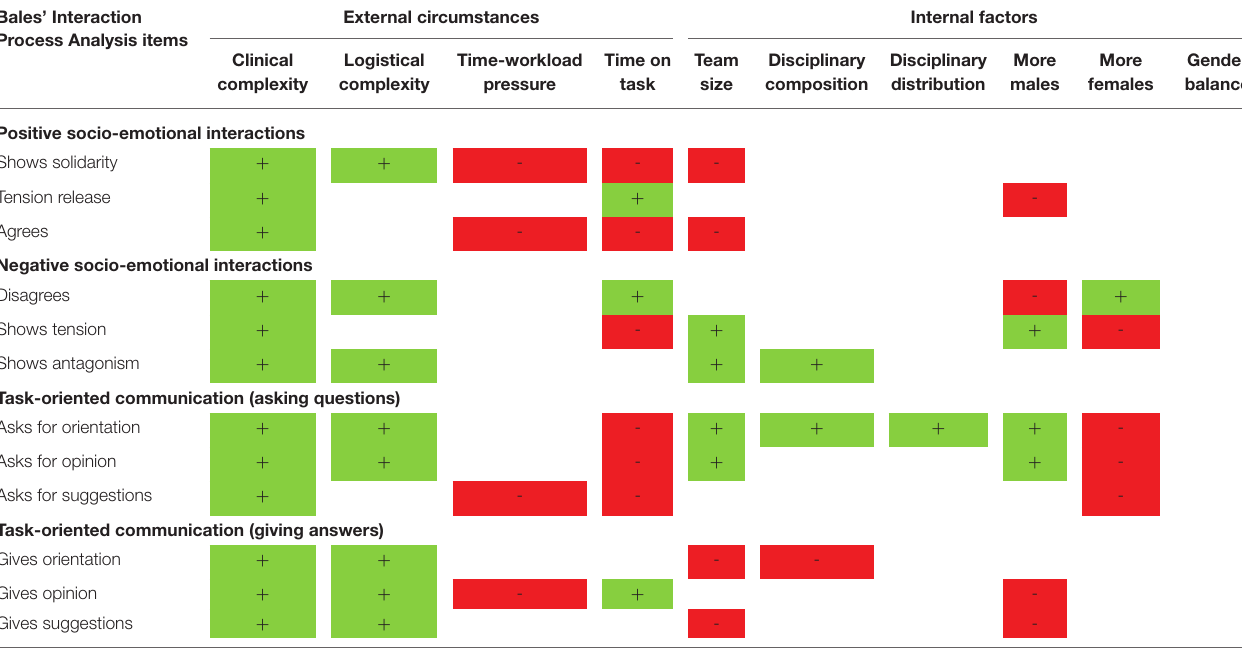
TABLE 5 | Overview of the relationship between Bales’ Interaction Process Analysis and external circumstances and internal factors. Bales’ Interaction Process Analysis